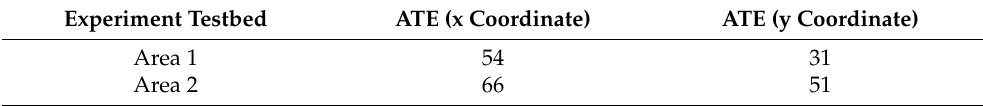
Table 3. Absolute trajectory error (ATE) in centimeters for Areas 1 and 2 and axis (x and y).